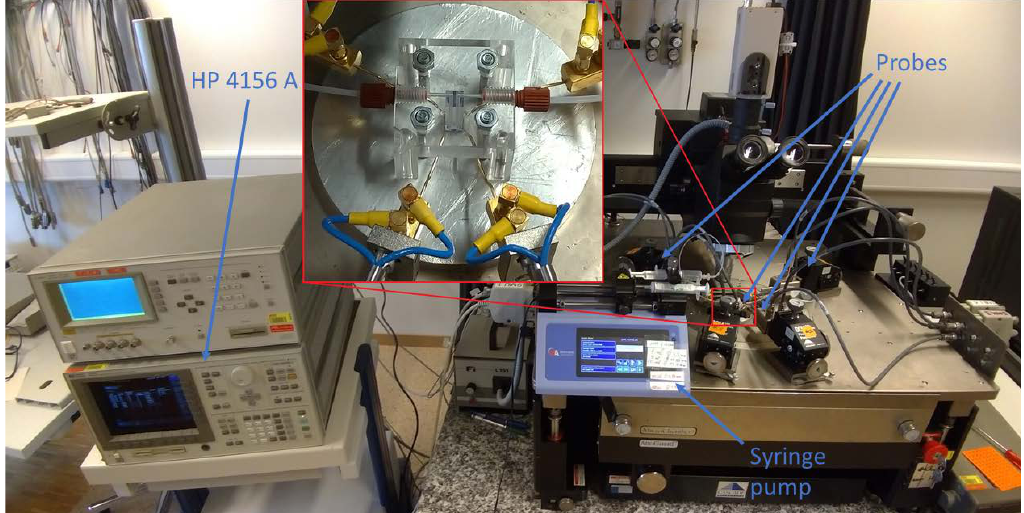
Figure 2. Measurement setup for the characterization of the BEOL ISFET. The HP 4156 A (on the left) applies the bias inputs and reads the current outputs from the device under test (DUT) through the four probes (on the right). A syringe pump provides a continuous flow of liquid on the chip through the PMMA microfluidics mounted on the chip